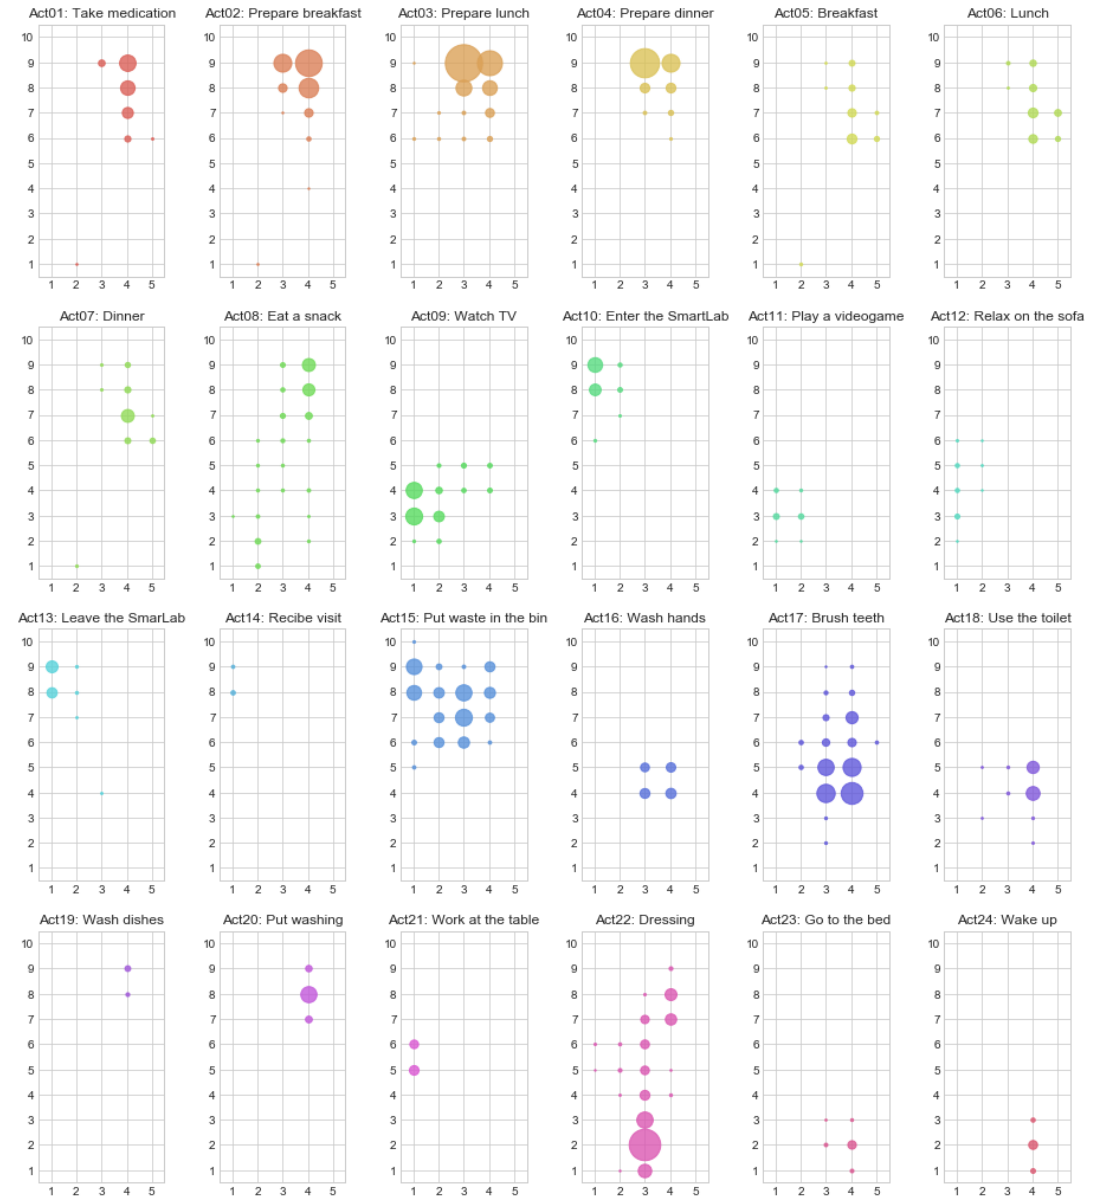
Figure A1. Activity